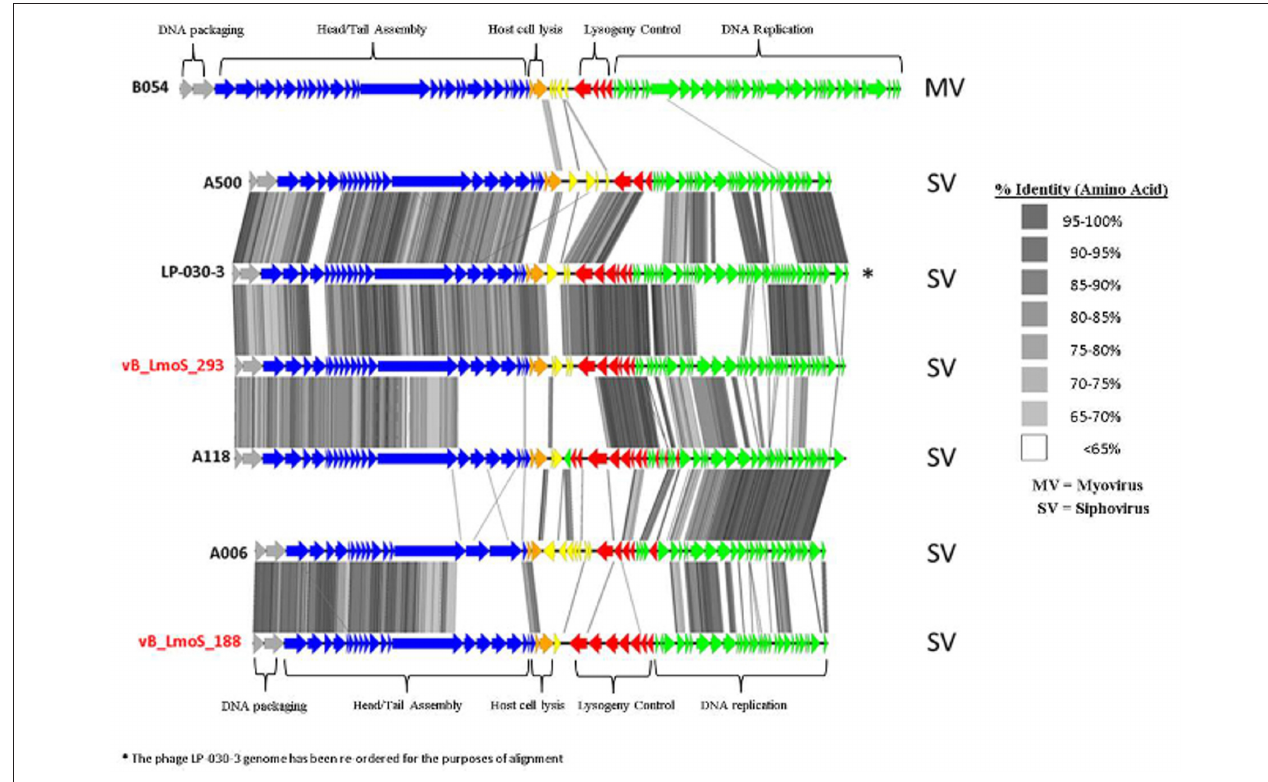
FIGURE 4 | Genome comparisons (amino acid level) of L. monocytogenes phages of Orthocluster IV, visualized in